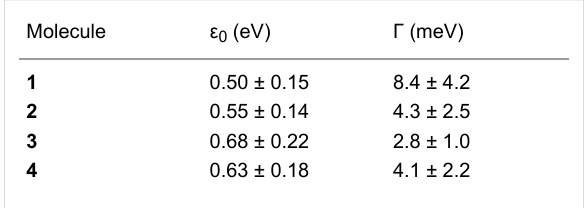
Table 2: Single-level model parameters extracted from the fit to the experimental I – V